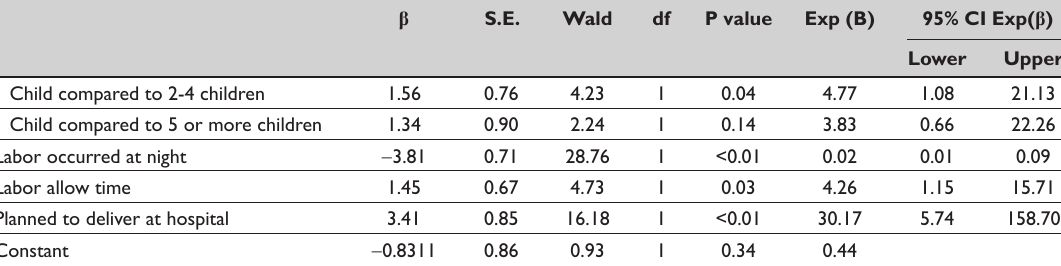
Table 5: Multiple logistic regression of predictors of choice of health facility